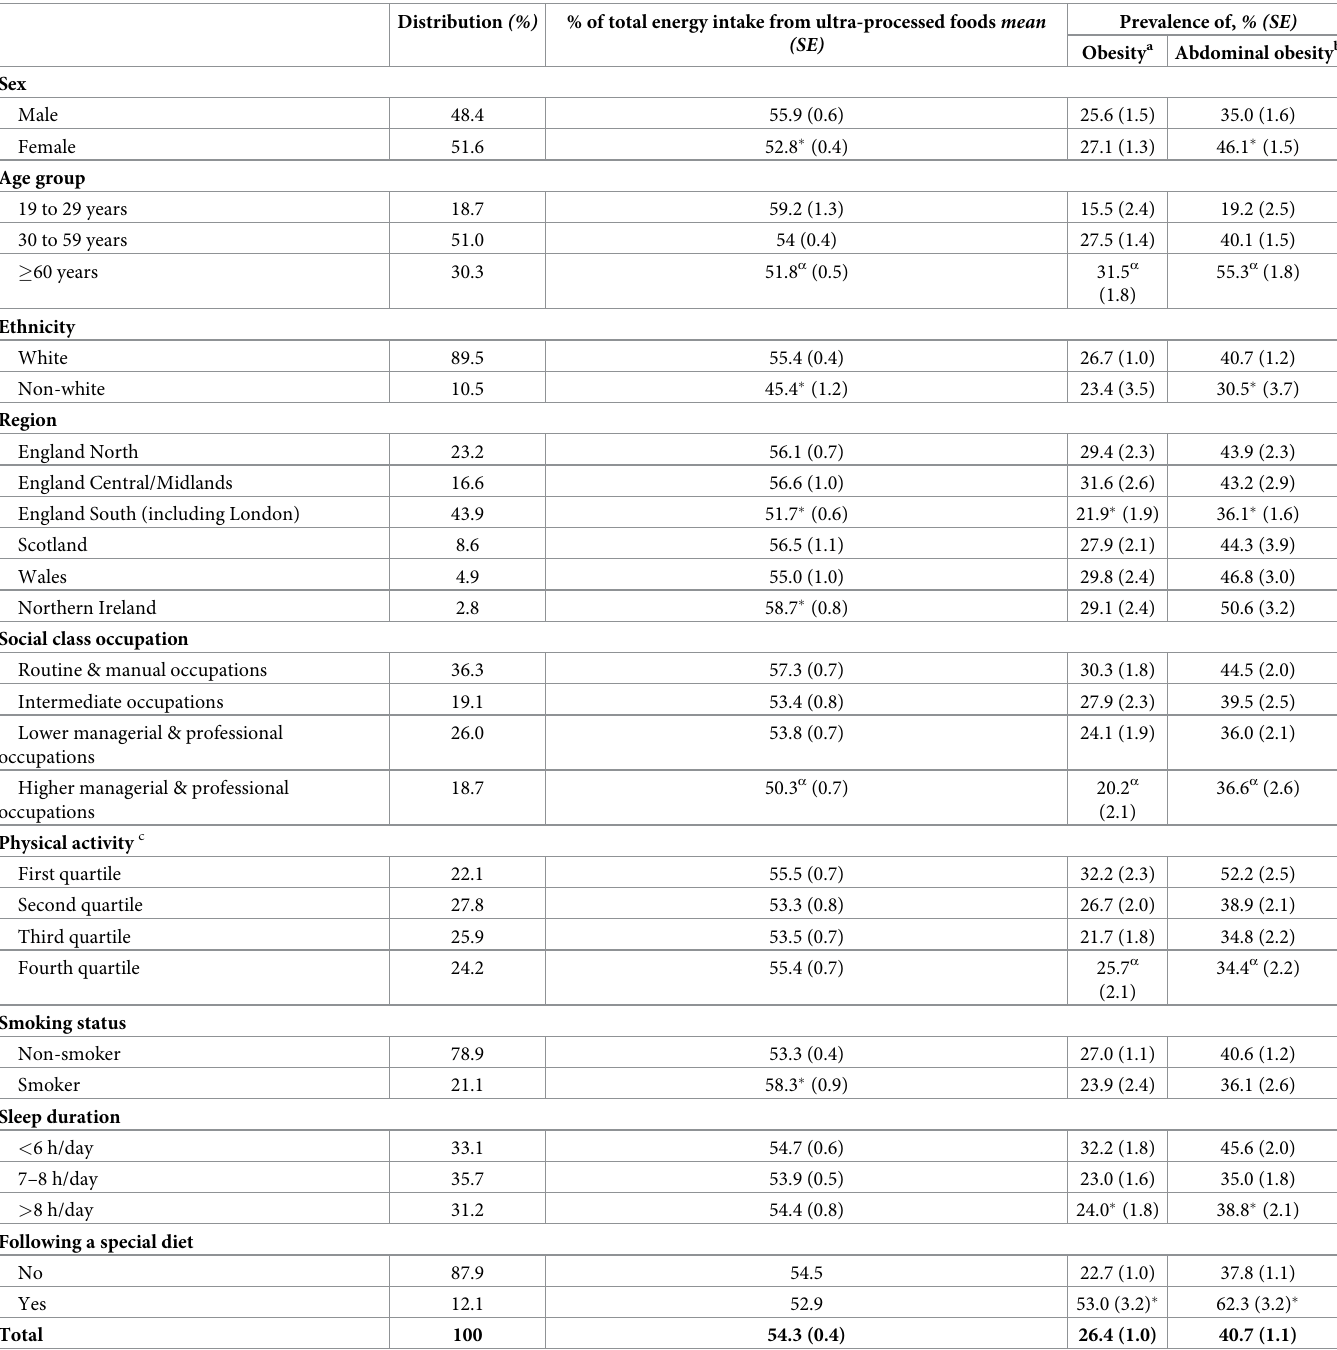
Table 2. Consumption of ultra-processed foods (% of total energy) and prevalence of obesity and abdominal obesity according to characteristics of the UK popula- tion aged 19 years or over (NDNS,